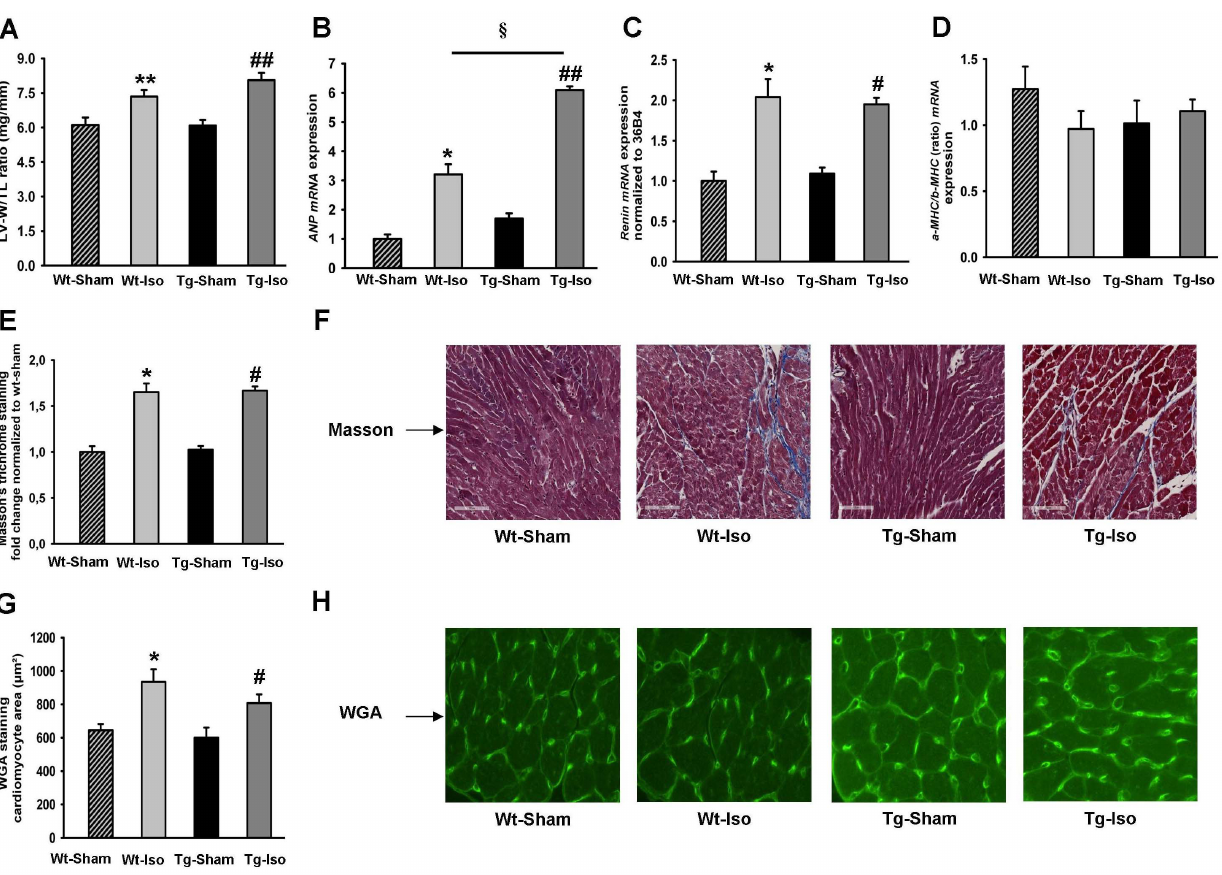
Figure 2. Assessment of isoproterenol induced cardiac hypertrophy in (P)RR transgenic mice. A) Left-ventricular weight (LV-W) to tibia length (TL)in adult Wt and Tg mice subjected to saline or ISO infusion for 28 days (N=7 mice in each group). B) ANP mRNA expression (normalized to 36B4 ) in adult Wt and Tg mice subjected to saline or ISO infusion for 28 days (N=7 mice in each group). C) Renin mRNA expression (normalized to 36B4 ) in adult Wt and Tg mice subjected to saline or ISO infusion for 28 days (N=7 mice in each group). D) a -MHC/ b -MHC (ratio) mRNA expression (normalized to 36B4 ) in adult Wt and Tg mice subjected to saline or ISO infusion for 28 days (N=7 mice in each group). E and F) Masson’s trichrome staining (bar size 100 m m) to assess myocardial fibrosis in adult Wt and Tg mice subjected to saline (sham procedure) or ISO infusion for 28 days; E: quantification, and F: typical examples of Masson’s trichrome staining. G and H) FITC-WGA staining to assess myocyte hypertrophy in adult Wt and Tg mice subjected to saline (sham procedure) or ISO infusion for 28 days; G: quantification, and H: typical examples of FITC-WGA staining. * P , 0.05, ** P , 0.01, sham vs. ISO between Wt mice; # P , 0.05, ## P , 0.01, sham vs. ISO between Tg mice and 1 P , 0.05, ISO treatment between Wt and Tg mice.